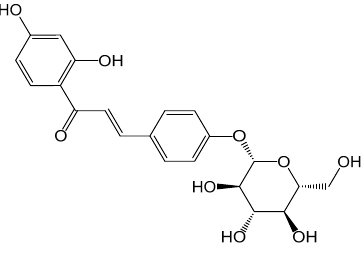
Figure 1. Structure of isoliquiritin.